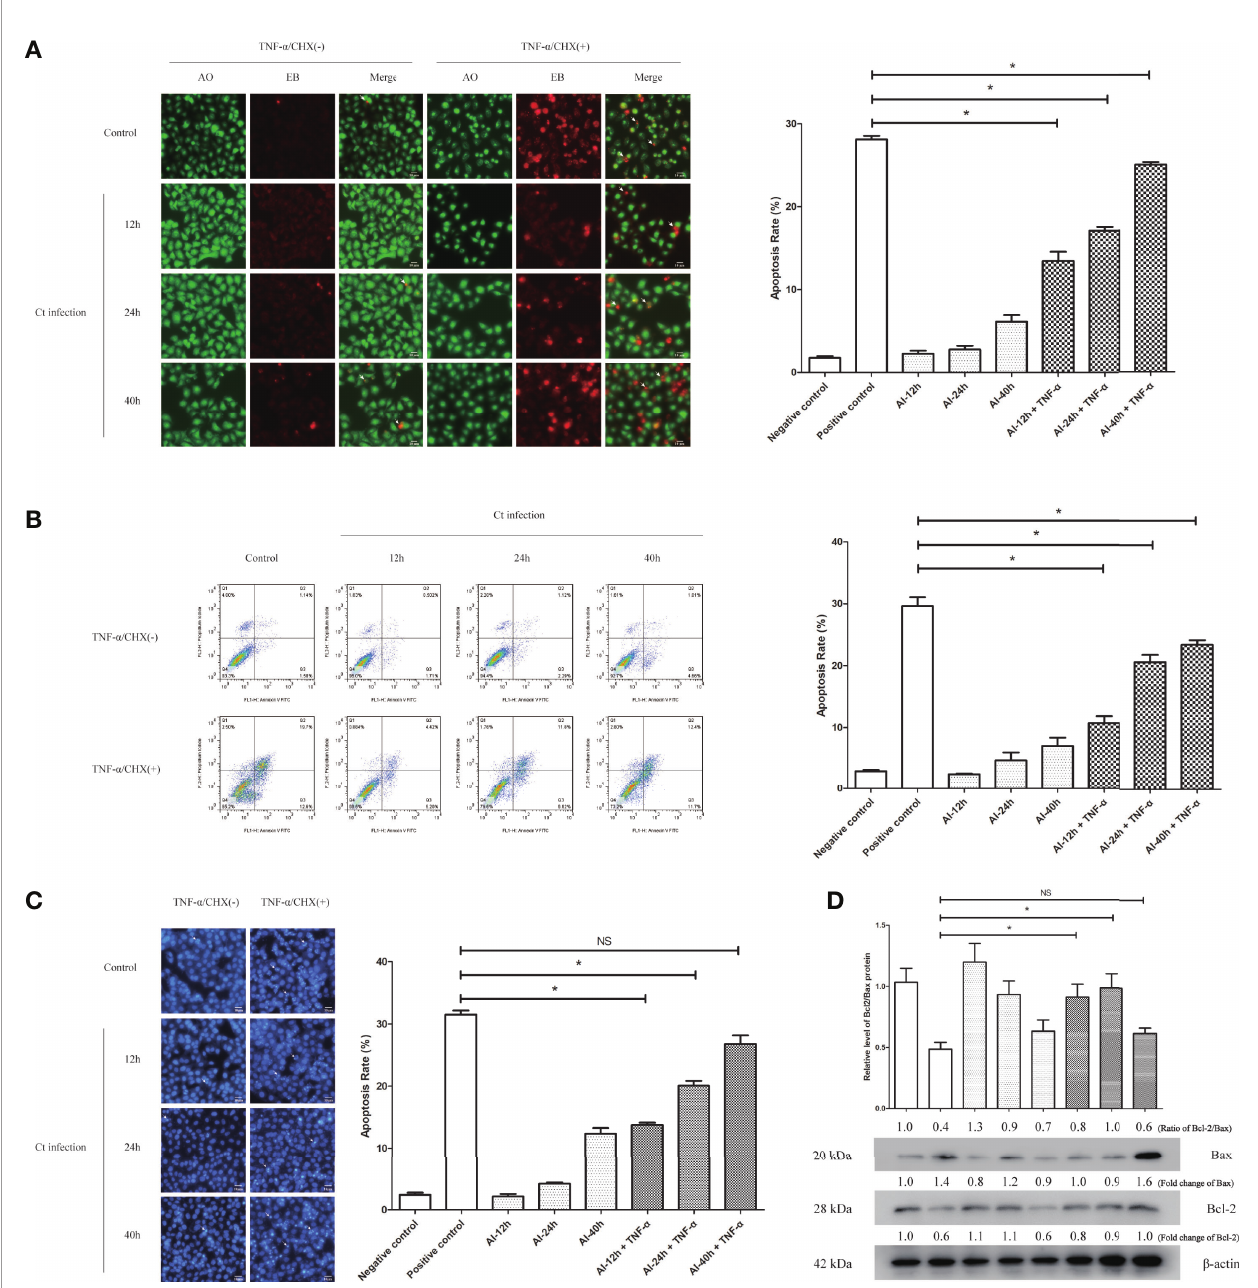
FIGURE 5 | The anti-apoptotic effect of chlamydial infection. (A) AO/EB staining (10 × 20), (B) FCM, and (C) Hoechst staining (10 × 20) for a Ct-infected cells at different points with TNF- a treatment. Right panel is the apoptosis rate calculated by corresponding experiment. * P < 0.05. NS, no signi fi cance. (D) The expression of Bcl2 and Bax was measured by western blot in HeLa cells and Ct-infected cells after the apoptosis induction. The upper panel is the ratio of Bcl2/Bax, and calculated by the corresponding gray value via Quantity One. Arrows in (A) denote apoptotic cells, and in (C) indicate apoptotic